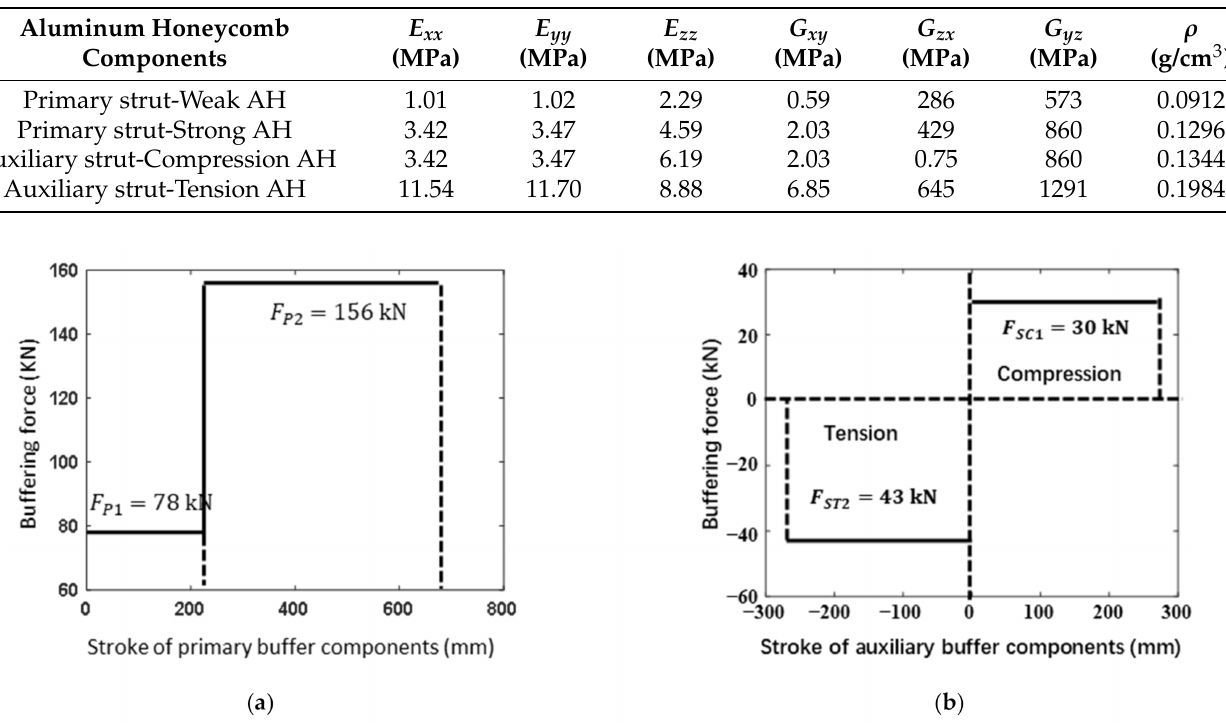
Figure 8. Buffering characteristics of aluminum honeycomb components within ( a ) primary and ( b ) auxiliary